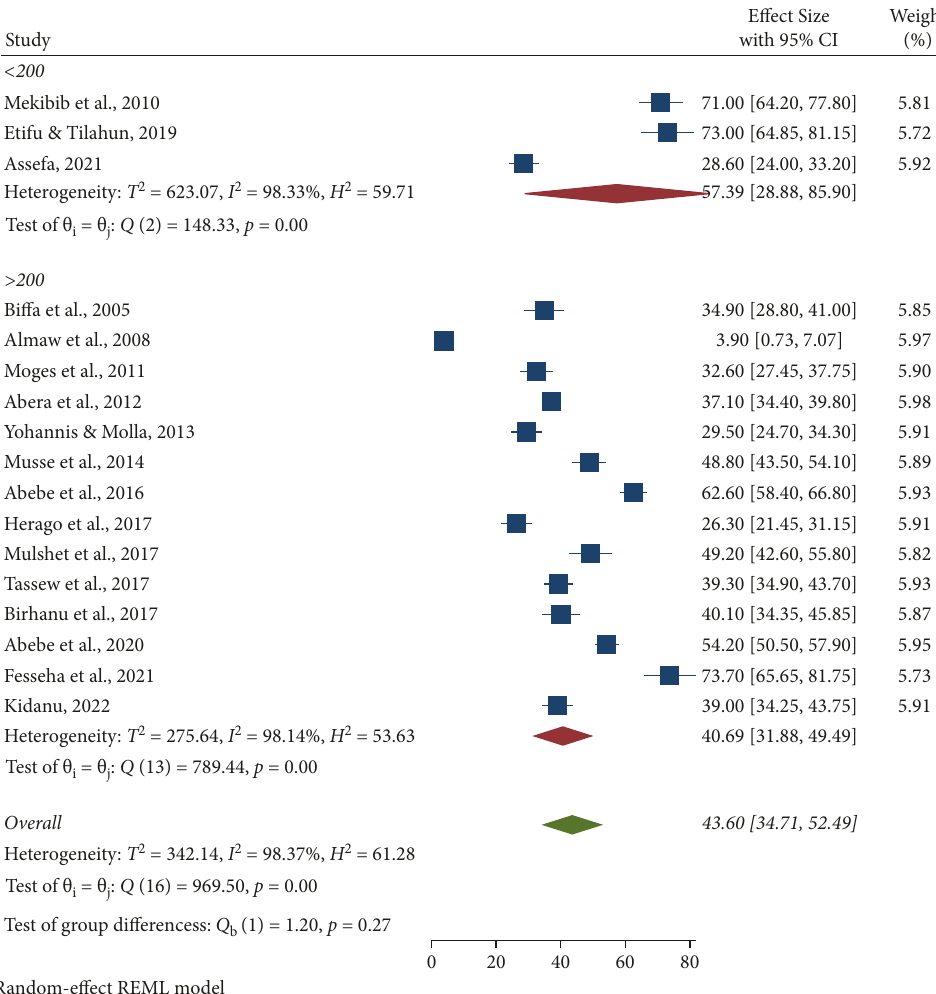
Figure 5: Pooled prevalence of bovine mastitis among dairy cows by sample